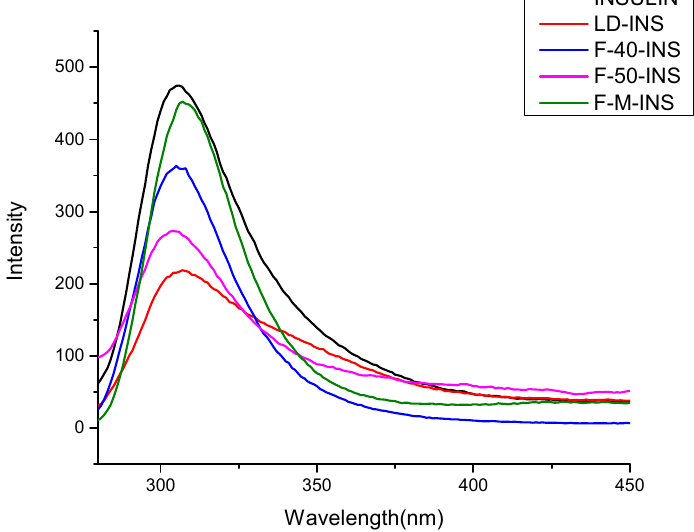
Figure 2. Fluorescence spectra of linear dextrin–insulin inclusion complexes: INSULIN, LD-INS, F-40-INS, F-50-INS, and F-M-INS.